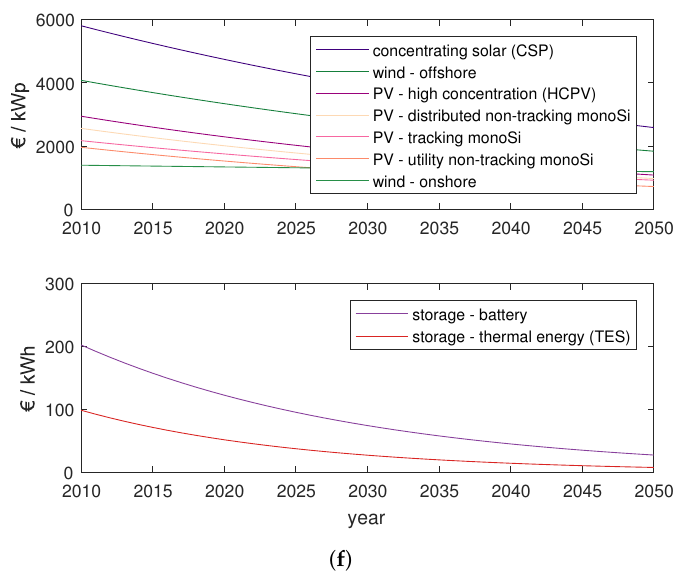
Figure A2. Cost assumptions in the sensitivity cases include: ( a ) The investment costs for all solar and wind electricity generation technologies (upper) and storage technologies (lower) in the lower solar cost scenario. Solar costs are curve fitted from [27] in this scenario. ( b ) The investment costs for all solar and wind electricity generation technologies (upper) and storage technologies (lower) in the lower HCPV cost scenario. HCPV costs are curve fitted from [27] in this scenario. ( c ) The investment costs for all solar and wind electricity generation technologies (upper) and storage technologies (lower) in the lower CSP cost scenario. CSP costs are curve fitted from [27] in this scenario. ( d ) The operations and maintenance costs for all renewable electricity generation technologies in the lower CSP cost scenario. CSP costs are curve fitted from [27] in this scenario. ( e ) The investment costs for all solar and wind electricity generation technologies (upper) and storage technologies (lower) in the lower wind cost scenario. Wind costs are curve fitted from [27] in this scenario. ( f ) The investment costs for all solar and wind electricity generation technologies (upper) and storage technologies (lower) in the lower storage cost scenario.